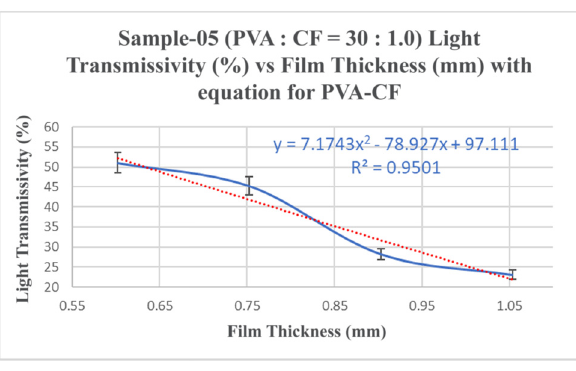
Figure 20: Sample - 05 ( CF:PVA = 1.0:30 ) light transmittance ( % ) versus fi lm thickness ( mm ) with equation for PVA - CF. The dotted lines represent the polynomial fi tted curve and the linear fi tted.